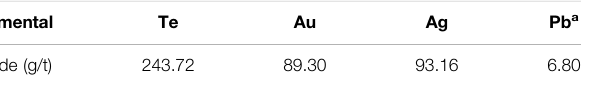
TABLE 1 | Chemical analysis results of major elements in telluride-type gold concentrate. Elemental Te Au Ag